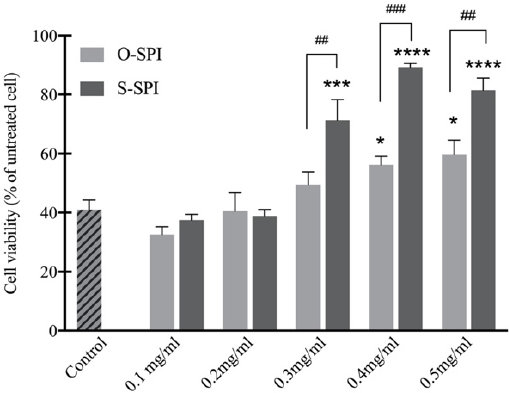
Figure 2. In vitro effect of S-SPI on cell viability as measured by MTT conversion (%). Caco-2 cells were incubated with 0.1–0.5 mg SPI/mL for 12 h and then treated with 400 µ M H 2 O 2 for 6 h. Values expressed as mean ± SEM ( n = 3). Significant differences between control group and other group are indicated by * p < 0.05, **** p < 0.001, **** p < 0.0001. Differences between O-SPI and C-SPI under same concentration are indicated by ## p < 0.01, ### p < 0.001. Differences are analyzed with a two-way analysis of variance (ANOVA) followed by a Tukey test.